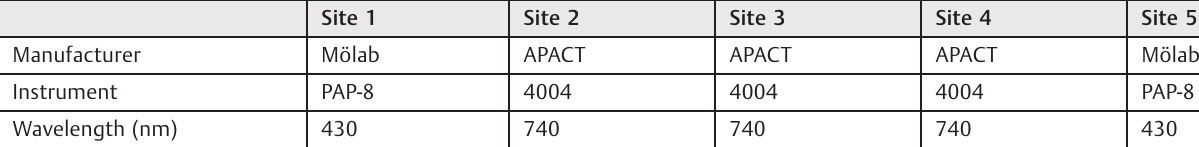
Table 4 Speci fi cations of the laboratory equipment used by the participating laboratories